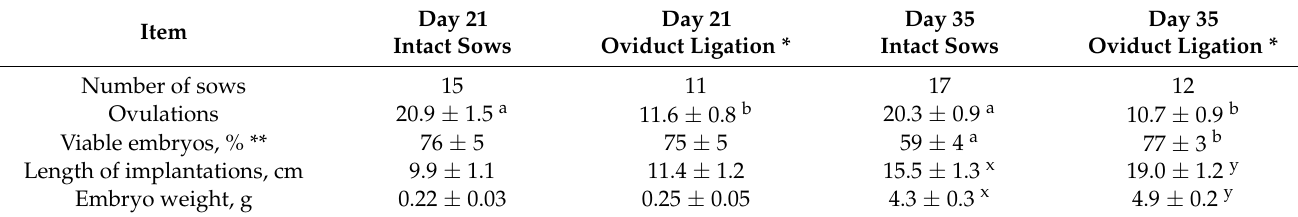
Table 1. Embryo survival and development at day 21 and day 35 of gestation in intact sows and in oviduct ligated sows, demonstrating the effect of uterine space (from Langendijk et al.